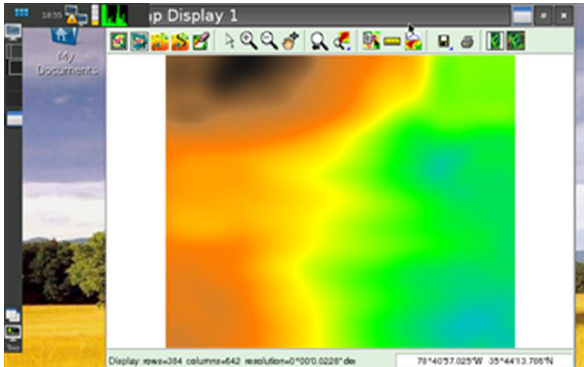
Figure 12. Elevation model in mobile